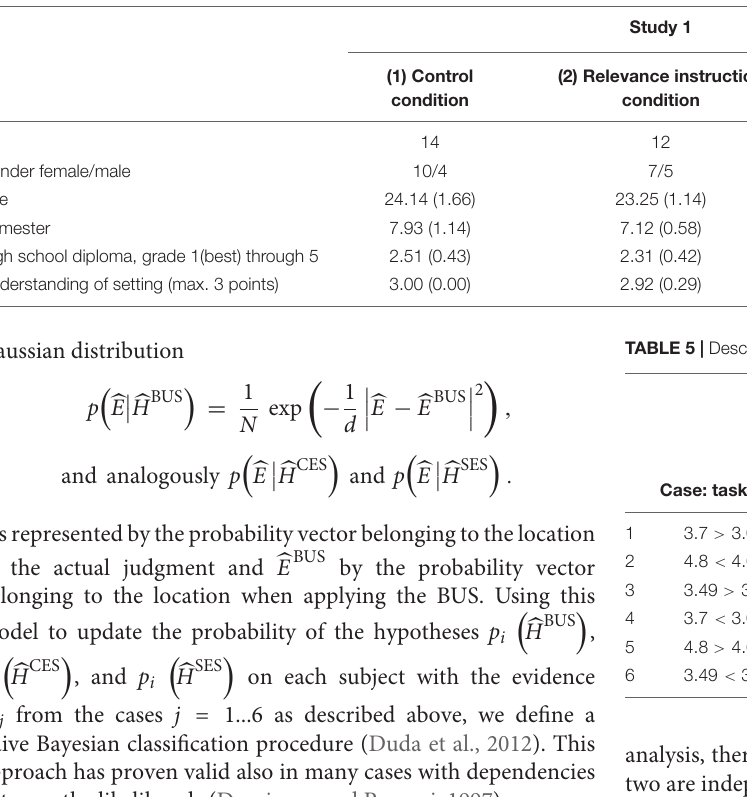
TABLE 4 | Descriptive statistics of participants of study 1 and study 2 [means (SD)].